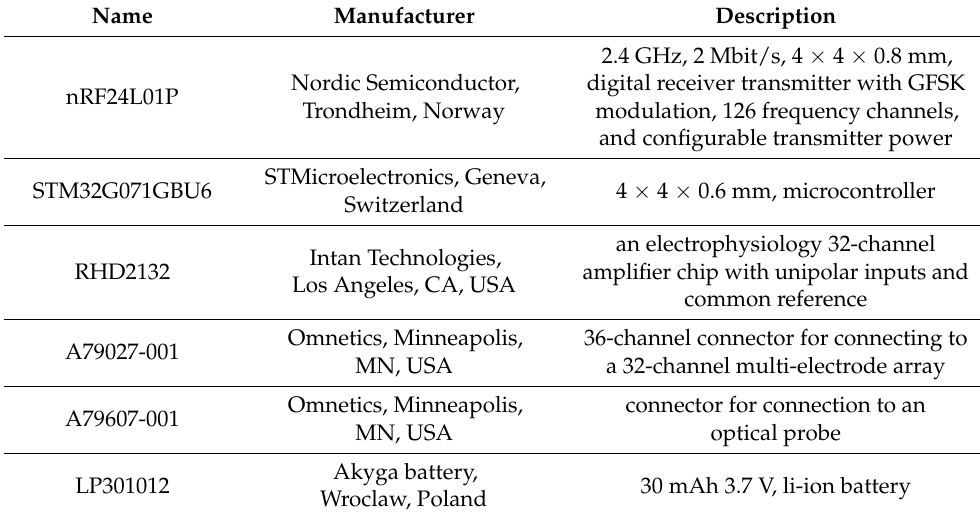
Table 2. Main components of the wireless module.